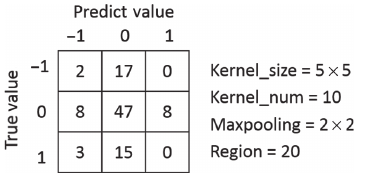
Figure 16: Confusion Matrix of Experiment 2 in Architecture 3.